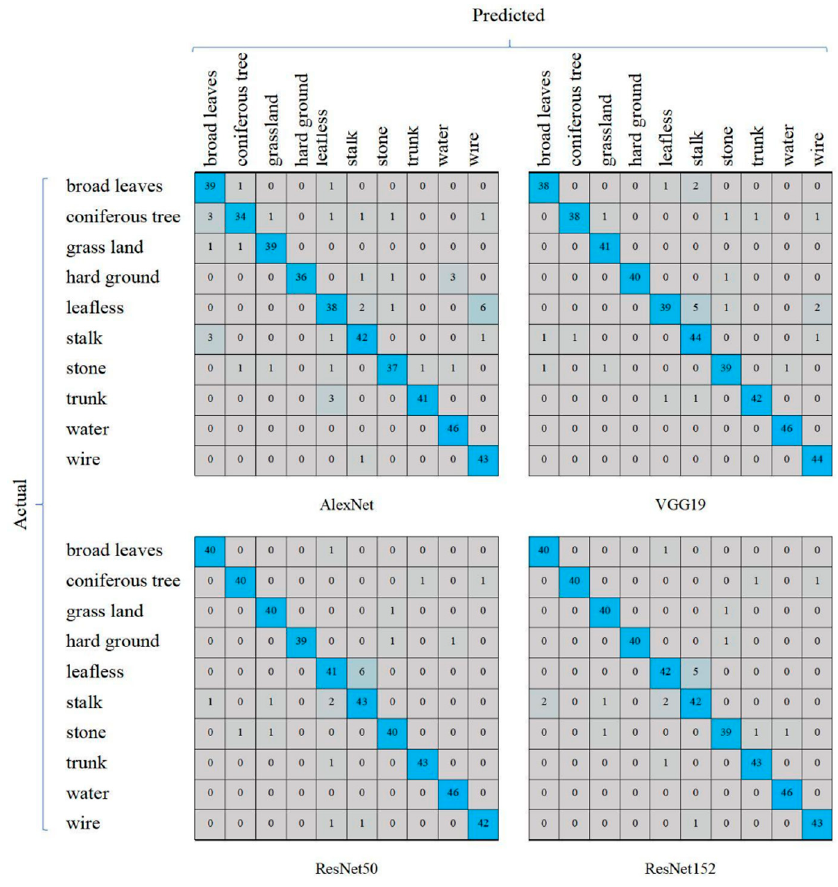
Figure 7. Confusion matrix (or error matrix) comparison among the above models. Taking the confusion matrix of AlexNet as an example, I and J represent the row number and column number of the elements in the matrix, respectively; then, the element (i, j) of each confusion matrix represents the number of predictions of category j given that the actual label was class i, with i and j referring to the classes from the category names at the left and top of the figure. Note that AlexNet recognized “leafless” as “wire” most times, while the other three networks did not. However, the other three networks confused “leafless” and “stalk” with each other.